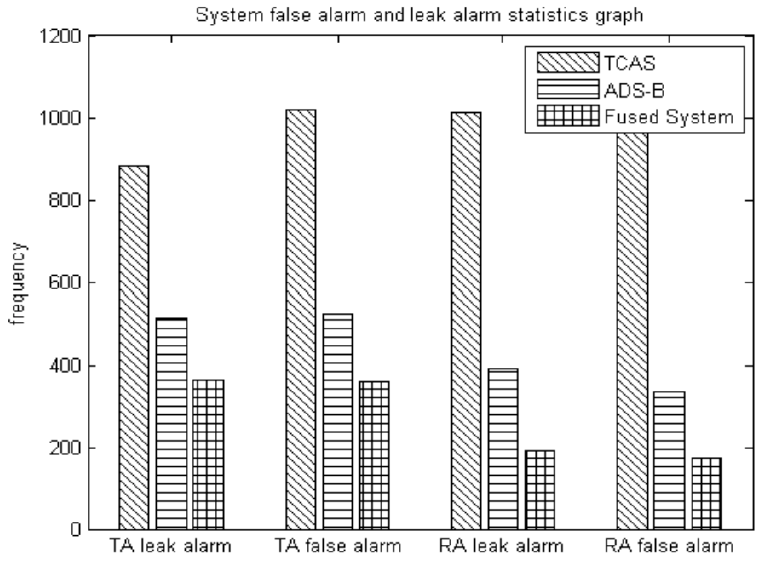
Table 2. Statistics of early alarm and hysteresis alarm during ta (35-45s), ra (<35s) in 200 experiments.